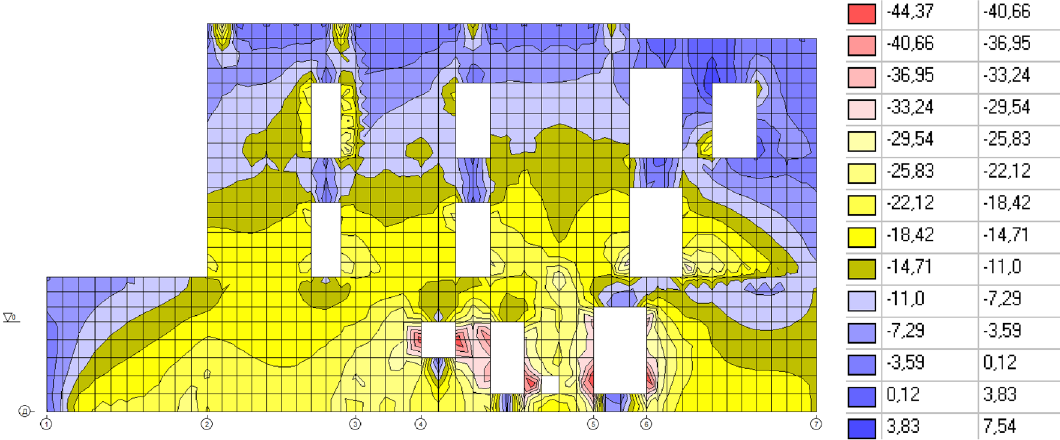
Figure 6. Vertical normal stresses in a brick wall along the “E” axis, t/m 2